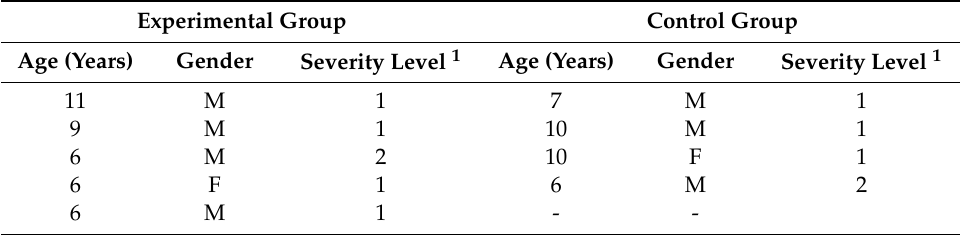
Table 1. Age, gender, and diagnosis of Children with ASD involved in the project. Experimental Group Control Group Age (Years) Gender Severity Level 1 Age (Years)